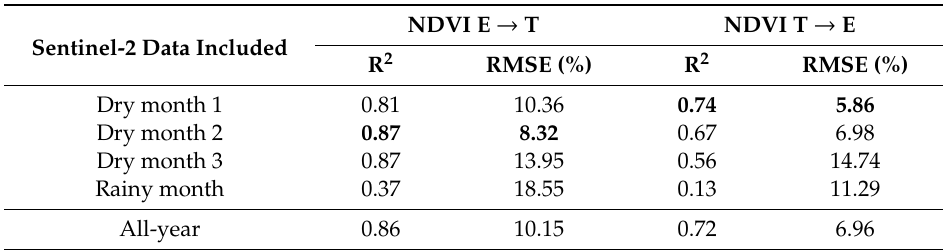
Table A1. R 2 and RMSE of the linear regression for the integrated models including Ethiopia and Tanzania (Scenario 2). E → T indicates that training data are taken from Ethiopia and tested on Tanzania, while T → E indicates training data from Tanzania tested on Ethiopia. The best performing model for each study site is marked in bold.